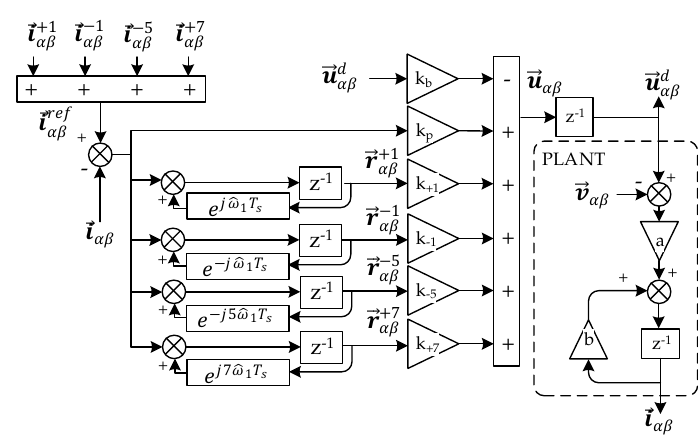
Figure 5. Current controller